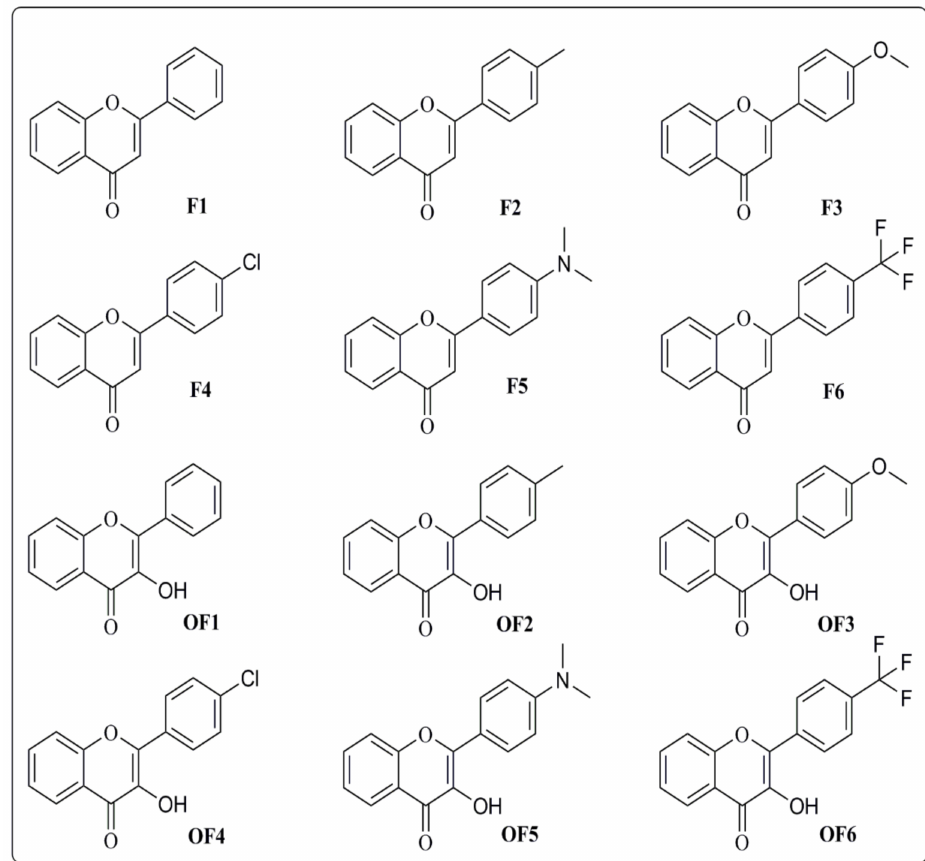
Figure 2. Synthetic compounds ( F1–F6 ) and ( OF1–OF6 ) used in the